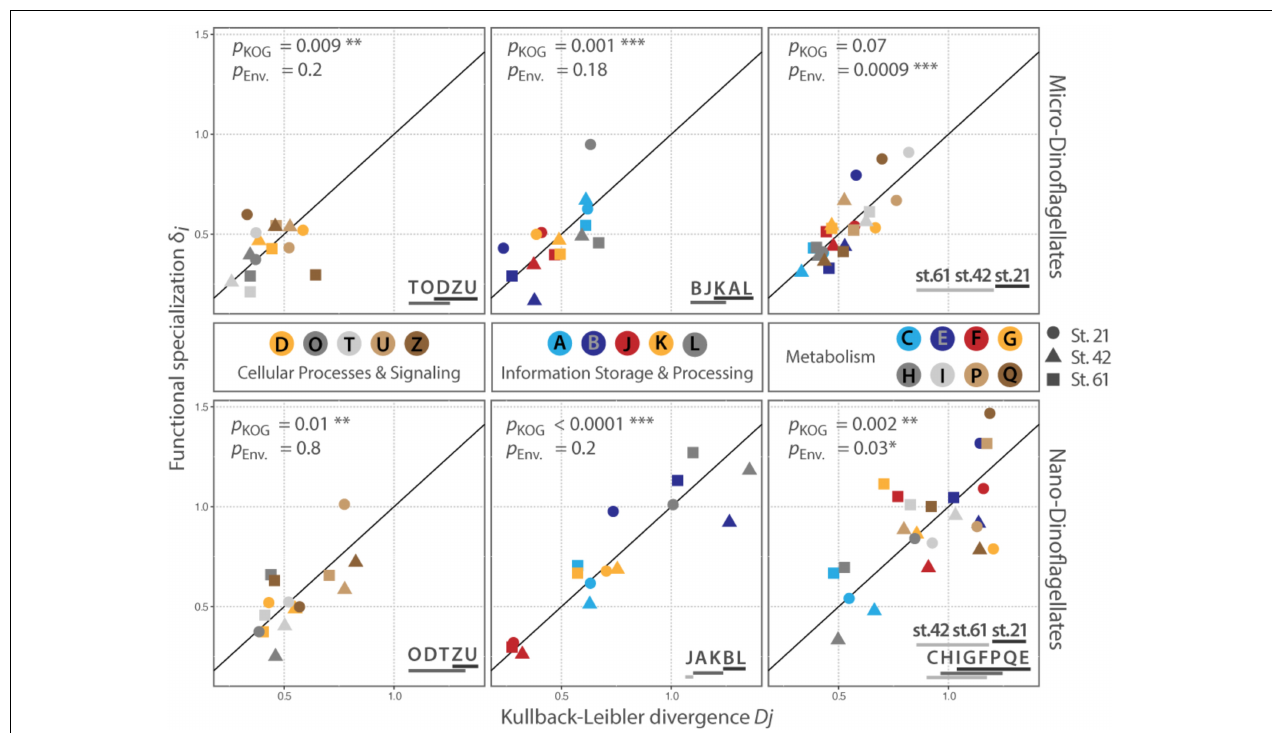
FIGURE 3 | Distribution of KOG-Categories along the conservation – plasticity gradient. The x-axis represents the Kullback–Leibler divergence D j ; the y -axis represented the functional specialization index δ i . The distance to the origin indicates the degree of plasticity with higher values for D j and δ i for categories that are more plastic. The reference line represents the conservation – plasticity gradient. Points above the line indicate plasticity by expressing mainly sample specific genes; points below the line represent plasticity by differential expression of transcripts common to all samples in the respective size class. p KOG gives p -values for the factor ‘category’ (between KOG-Category variances); p ENV gives p -values for the factors ‘station per category’ (within KOG-Category variances). Asterisks indicate the level of significance: ∗ P ≤ 0.05, ∗∗ P ≤ 0.01, ∗∗∗ P ≤ 0.001. Lines below letters on the bottom right show statistically homogenous subsets for each significant factor. Each letter abbreviates a functional category; names of the functional categories are according to KOG. J: translation, ribosomal structure and biogenesis, A: RNA processing and modification, K: transcription, L: replication, recombination and repair, B: chromatin structure and dynamics, D: cell cycle control, cell division, chromosome partitioning, O: posttranslational modification, protein turnover, chaperones, T: signal transduction mechanisms, U: intracellular trafficking, secretion, and vesicular transport, Z: cytoskeleton, C: energy production and conversion, G: carbohydrate transport and metabolism, E: amino acid transport and